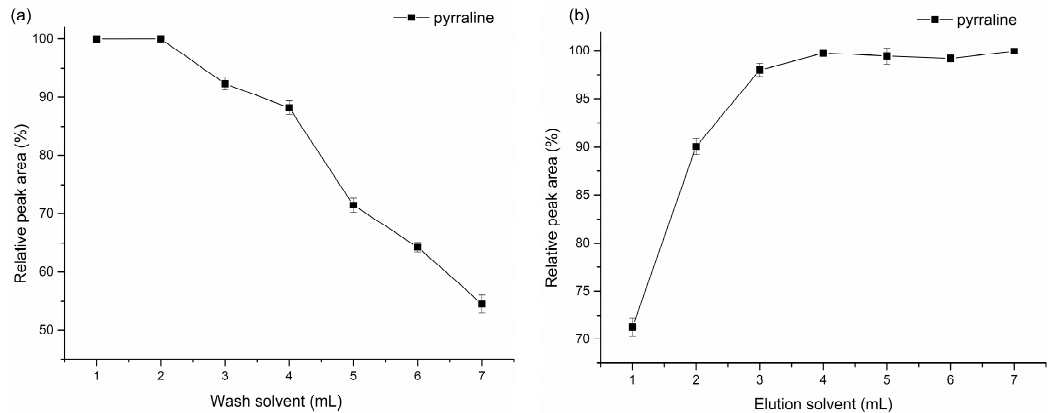
Figure 4. Relationship between volume of washing solvent and recovery of pyrraline ( a ); and relationship between volume of elution solvent and recovery of pyrraline ( b ). ( a ) Volume of elution solvent was 4 mL, the recovery obtained using the least volume of the washing solvent (1 mL) was taken as 100, and the data were expressed as relative peak area; ( b ) Volume of washing solvent was 2 mL, the recovery obtained using the volume of the elution solvent (7 mL) was taken as 100, and the data were expressed as relative peak area